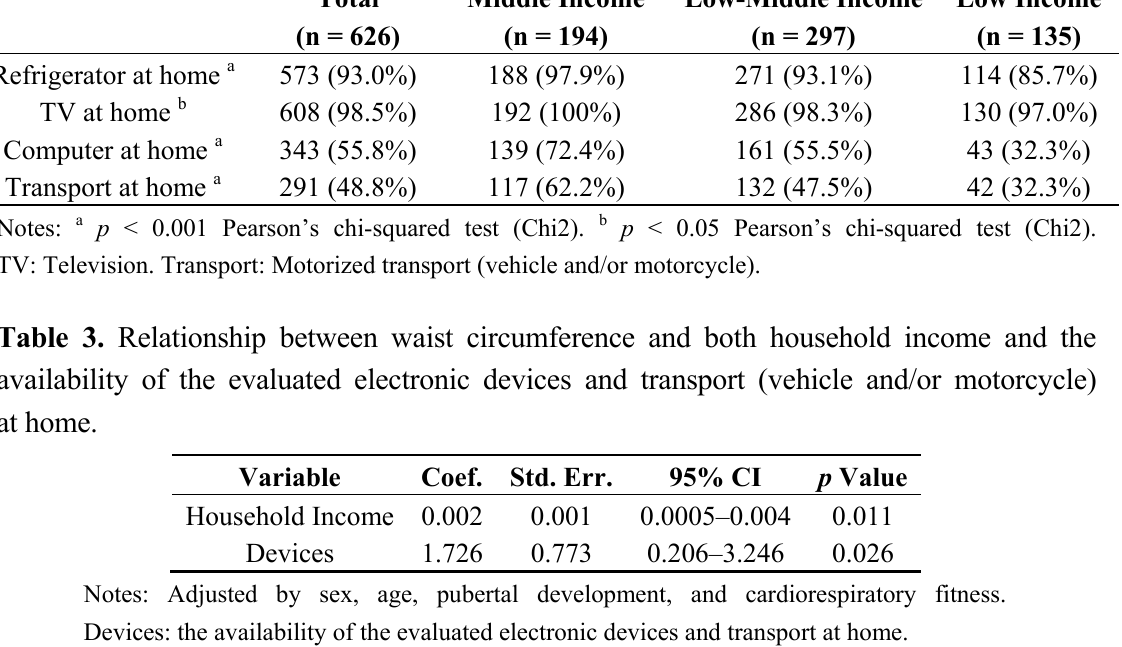
Table 2. Association between socioeconomic status and the availability of the evaluated electronic devices and transport (vehicle and/or motorcycle) at home. Total Middle Income Low-Middle Income Low Income (n = 626) (n = 194) (n = 297) (n = 135) Refrigerator at home a 573 (93.0%) 188 (97.9%) 271 (93.1%) 114 (85.7%) TV at home b 608 (98.5%) 192 (100%) 286 (98.3%) 130 (97.0%) Computer at home a 343 (55.8%)